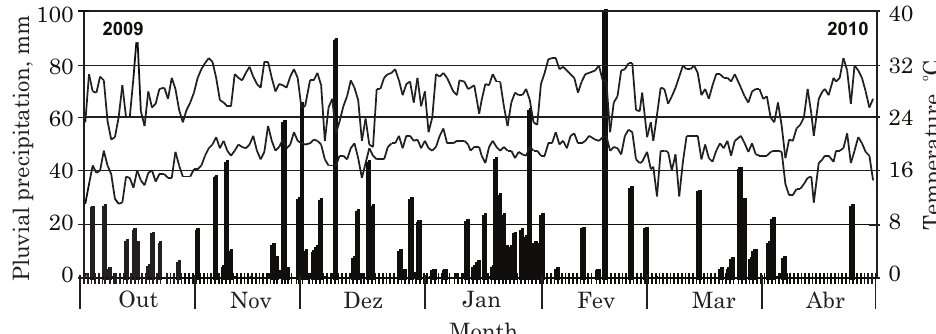
Figure 1. Precipitation ( ), maximum ( ) and minimum ( ) temperatures during the